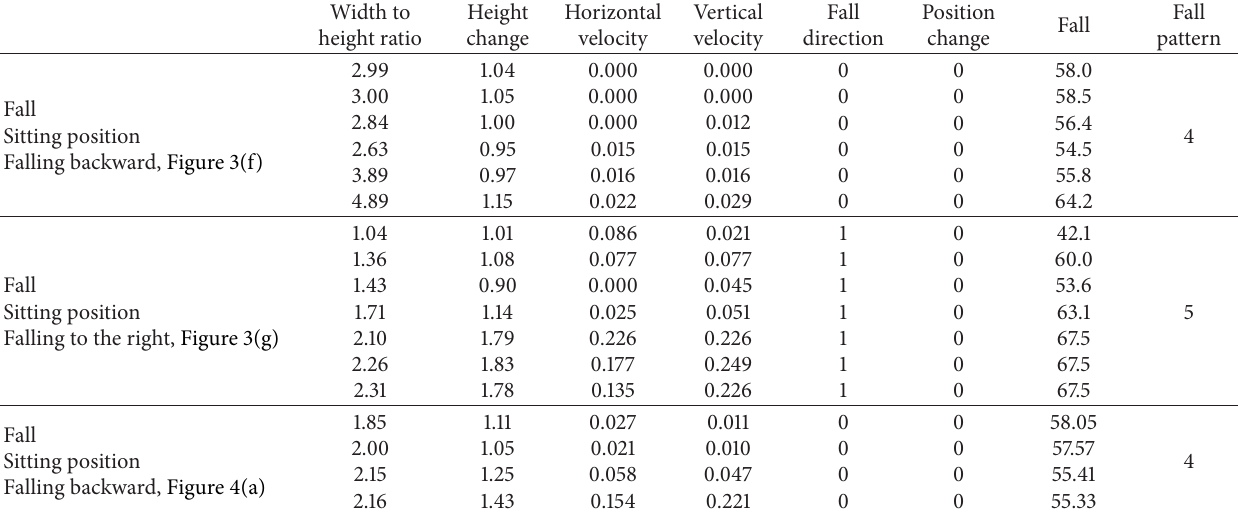
Table 2: Results of fall detection and fall pattern recognition from a “sitting” position in infrared and colour.